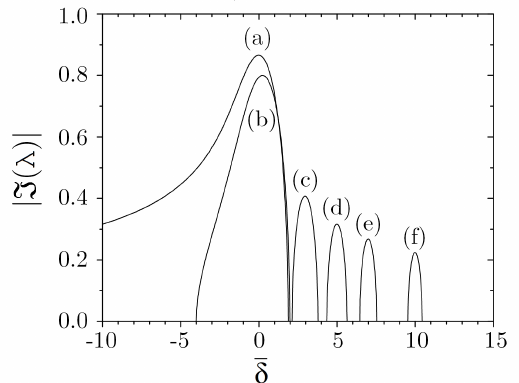
Figure 6. |(cid:61) ( λ ) | vs. ¯ δ for ¯ κ = 0 and different values of 1/ ρ : (a) 0, (b) 1, (c) 6, (d) 10, (e) 14 and (f) 20.